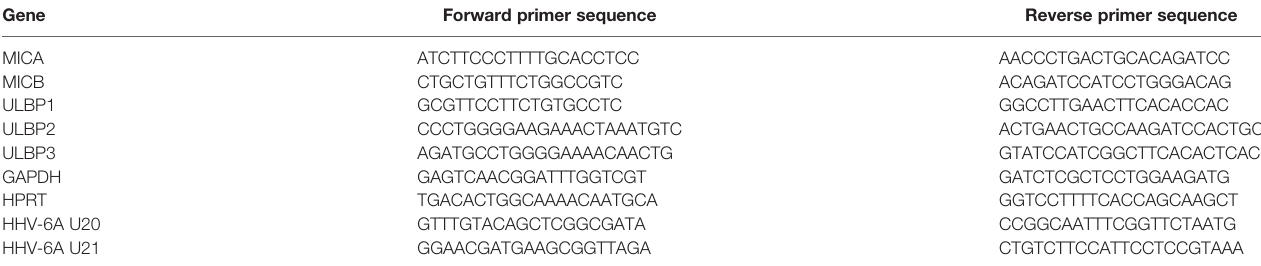
TABLE 1 | Primer pairs for human and viral genes used in qPCR. Gene Forward primer sequence Reverse primer sequence